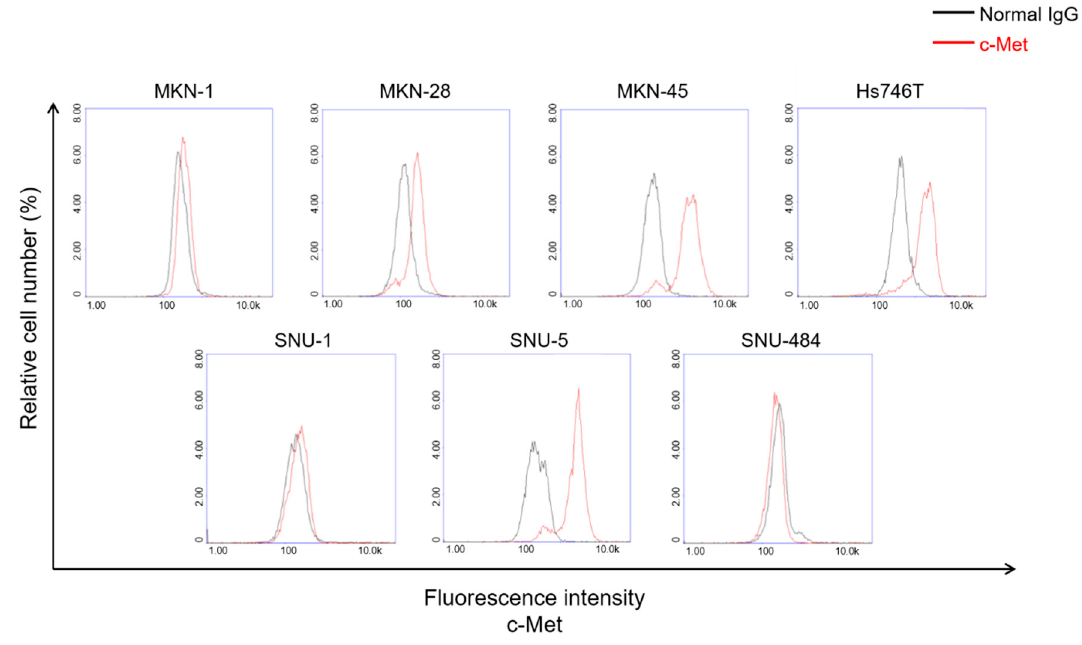
Figure 2. Analysis of surface c-Met expression in several GC cell lines. Several GC cell lines were stained with c-Met antibody to see the c-Met level on the cell